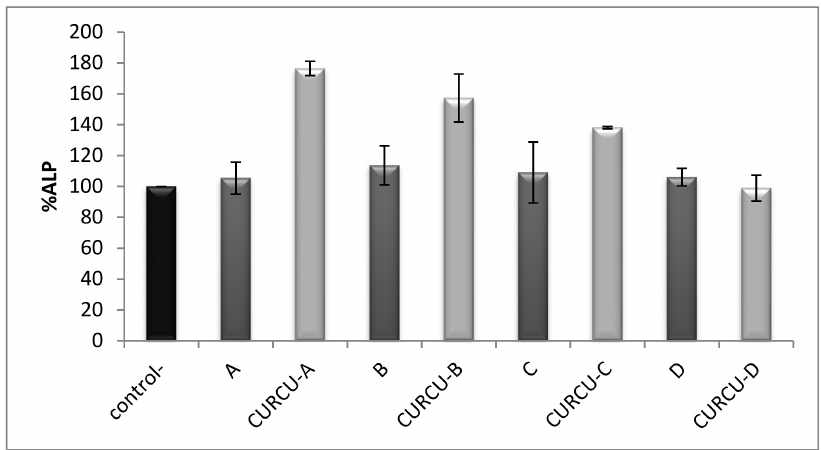
Figure 7. Quantification of ALP activity on MG63 cells 5 days after treatment with 50 µ g/mL of each bone graft with or without curcumin loading. In the control group, control-, the cells were maintained in 1% FBS. The results are presented as mean ± standard error (SE) of three independent